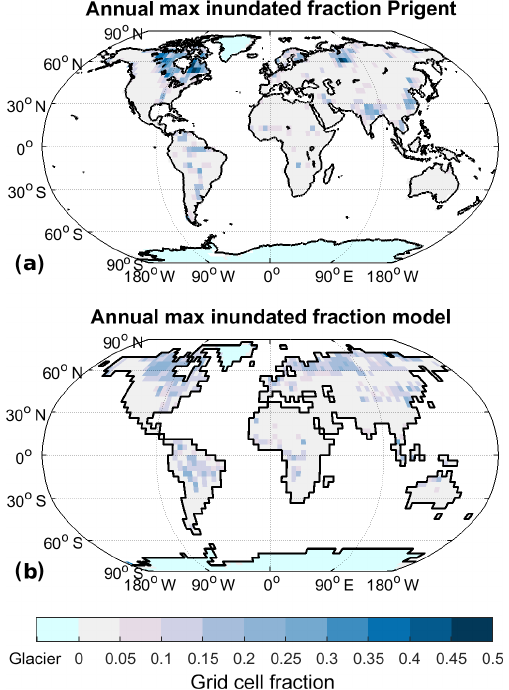
Figure 3. Annual maximum of mean monthly inundated fraction for Prigent et al. (2012) (a) and model (b)